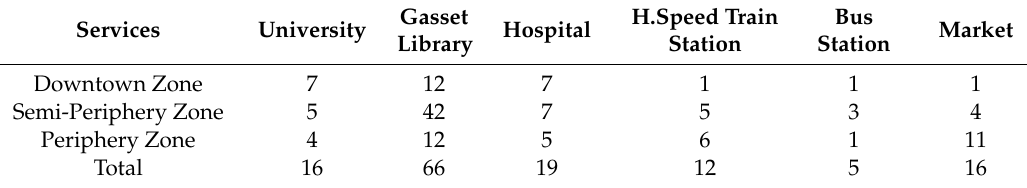
Table A6. Results of answers related to city